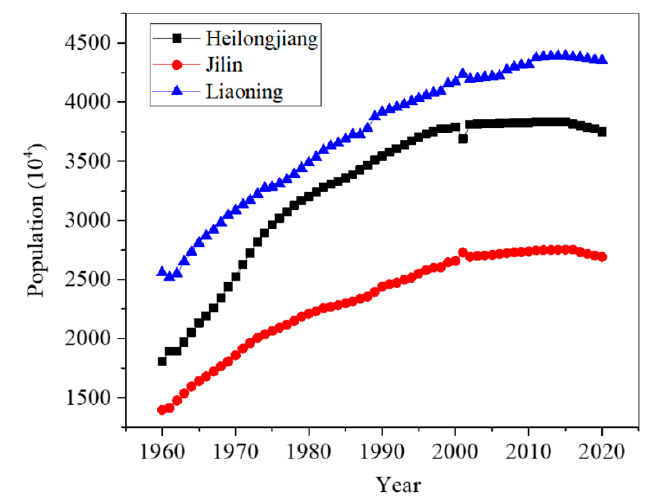
Figure 8. Annual changes of population in Heilongjiang, Jilin, and Liaoning Provinces during 1960–2020.